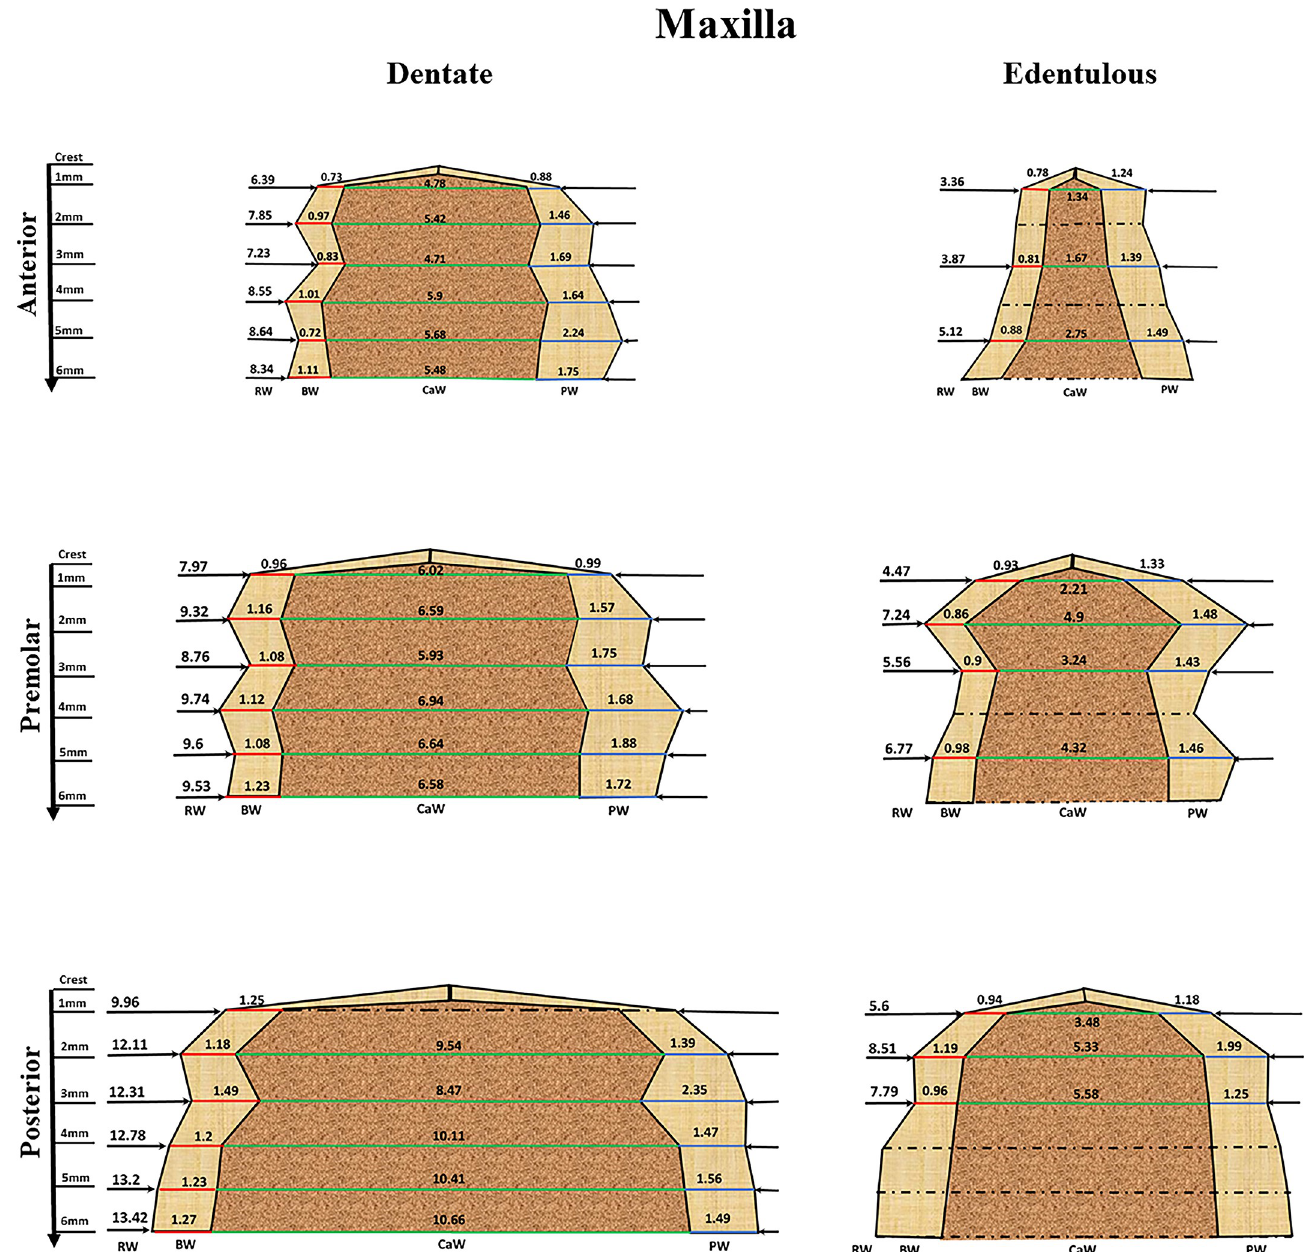
Fig 4. The maxillary dentate and edentulous ridge. The fig was constructed by using the combined mean obtained from the meta-analysis results for the RW (Ridge width) marked by a black line. BW (Buccal width) marked by a red line and PW (Palatal width) marked by a blue line and the calculated CaW marked by green line. The interrupted lines represent an estimated